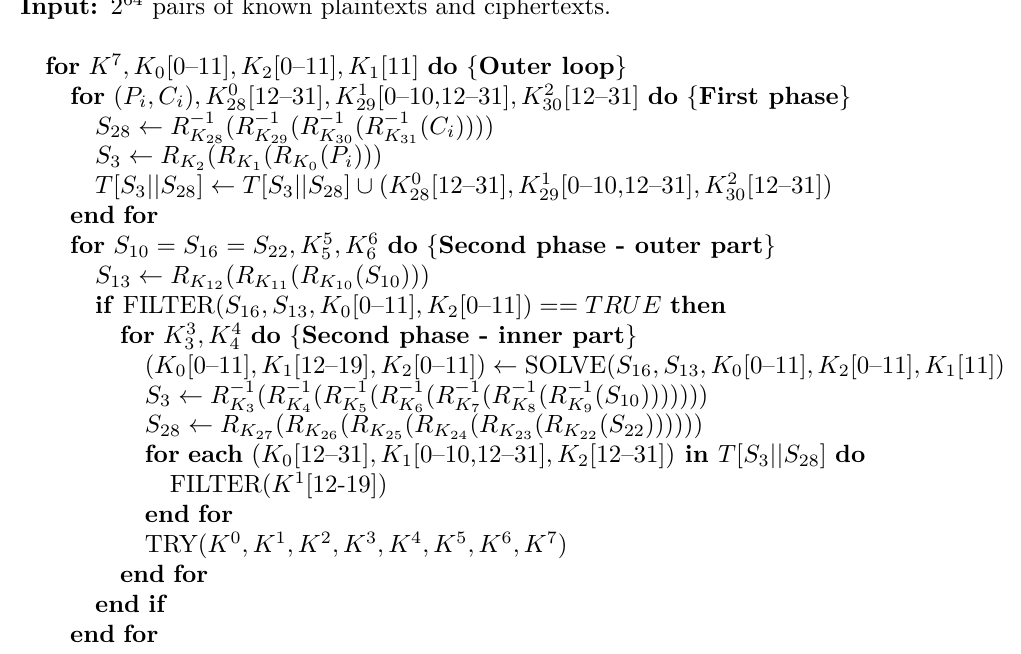
Algorithm 3 Pseudocode of the fixed-point attack against